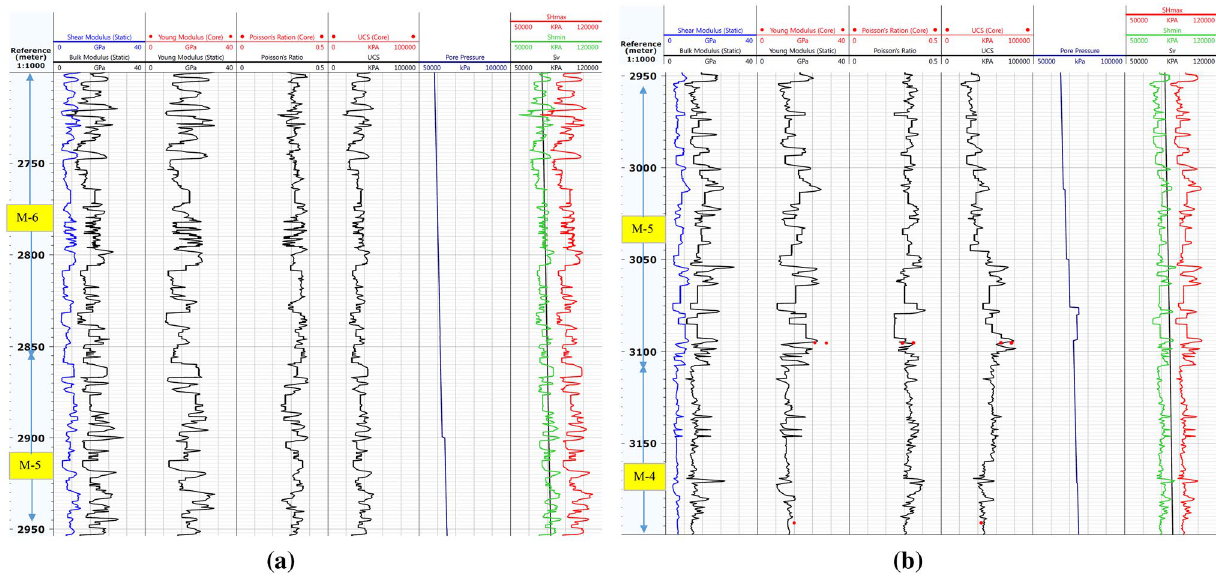
Fig. 11 a The MEM geomechanical parameters for Gachsaran formation in well Z26 (2700–2950 m). b The MEM geomechanical parameters for well Z26 (2950–3200